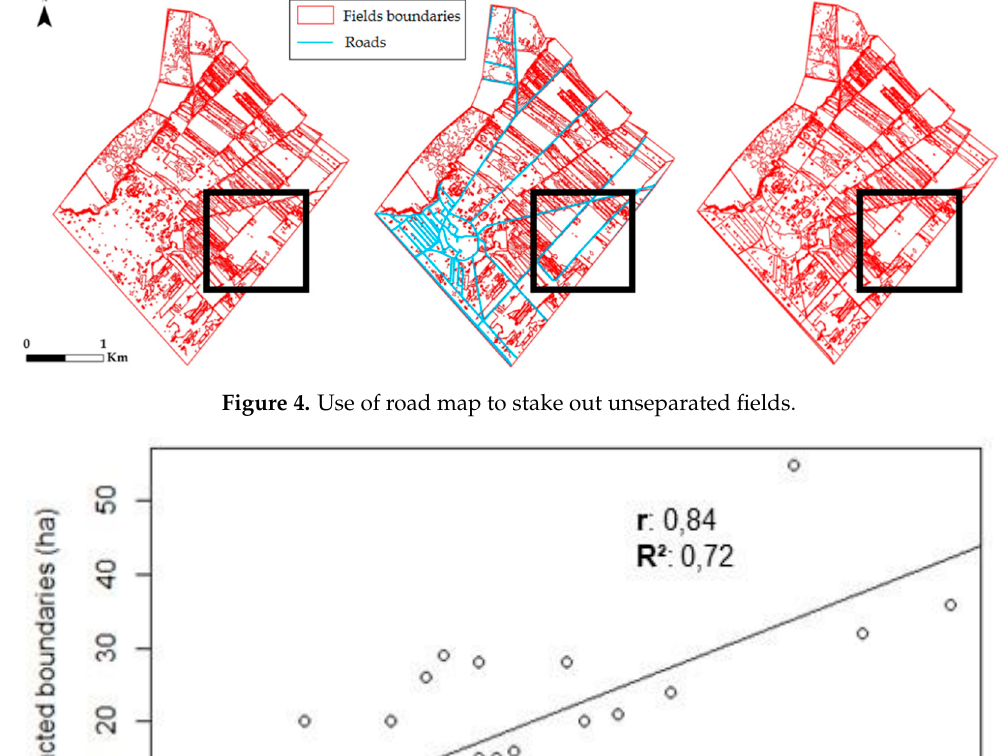
Figure 3. Extract of the NDVI value evolution above 0.4 in the Bekaa Valley in 2017 (sample). a : March;